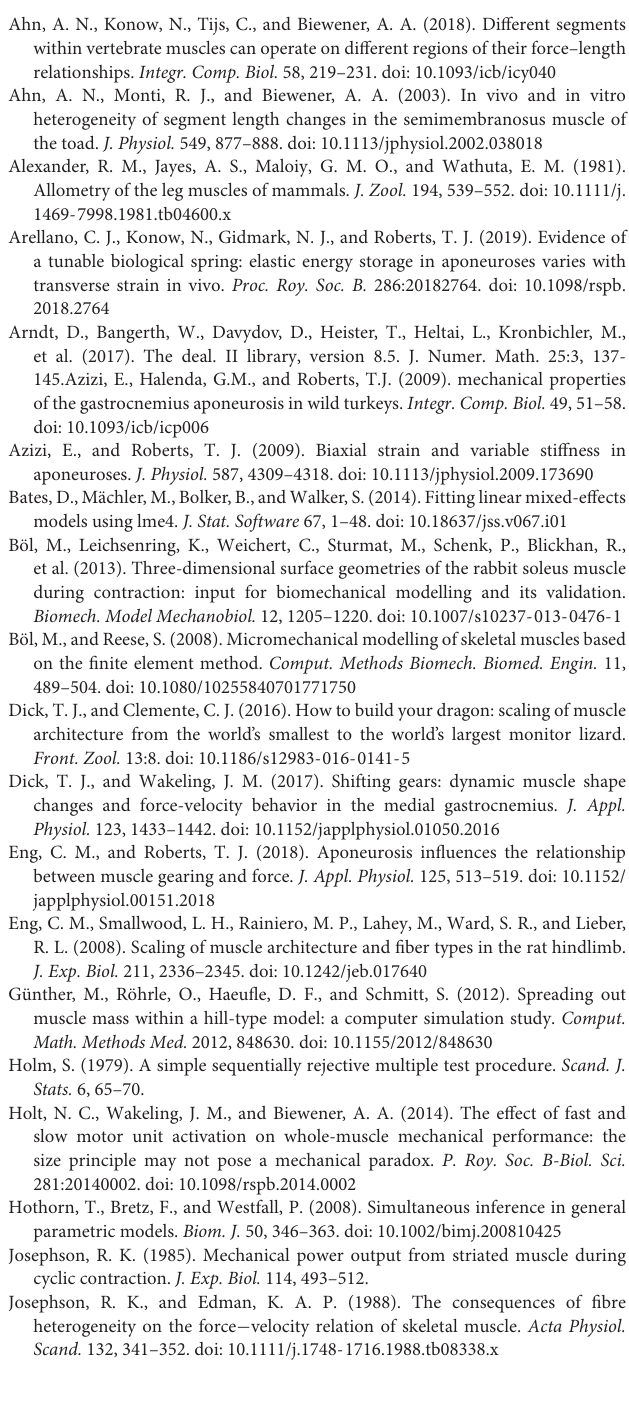
Supplementary Figure 1 | Local velocity of quadrature points over time. x (A) , y (B) , and z (C) components of the local velocity in the current direction (shading) of quadrature points as a function of their current z and x positions for a sample simulation with scale 1, initial pennation angle of 15.3 ◦ , maximum normalised excitation of 1, and maximum strain amplitude of 5%. We measured the local